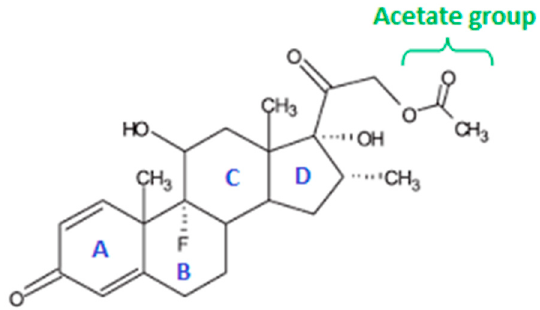
Figure 1. Chemical structure of dexamethasone-21-acetate with perhydro-cyclopentano-phenanthrene Figure 1 . Chemical structure of dexamethasone-21-acetate with perhydro-cyclopentano- ring system, A = A-ring, B= B-ring, C= C-ring, and D = phenanthrene ring system, A = A-ring, B= B-ring, C= C-ring, and D = D-ring.